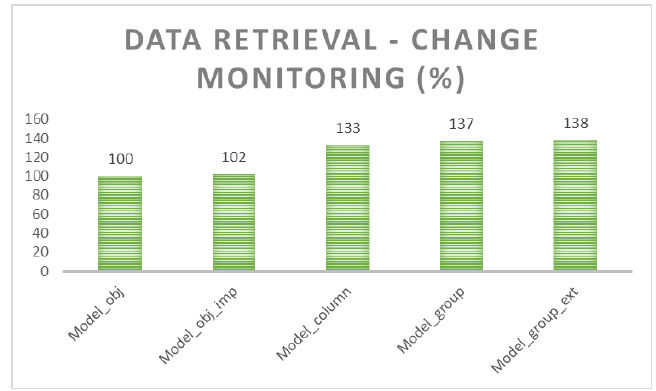
Figure 20. Data retrieval (change